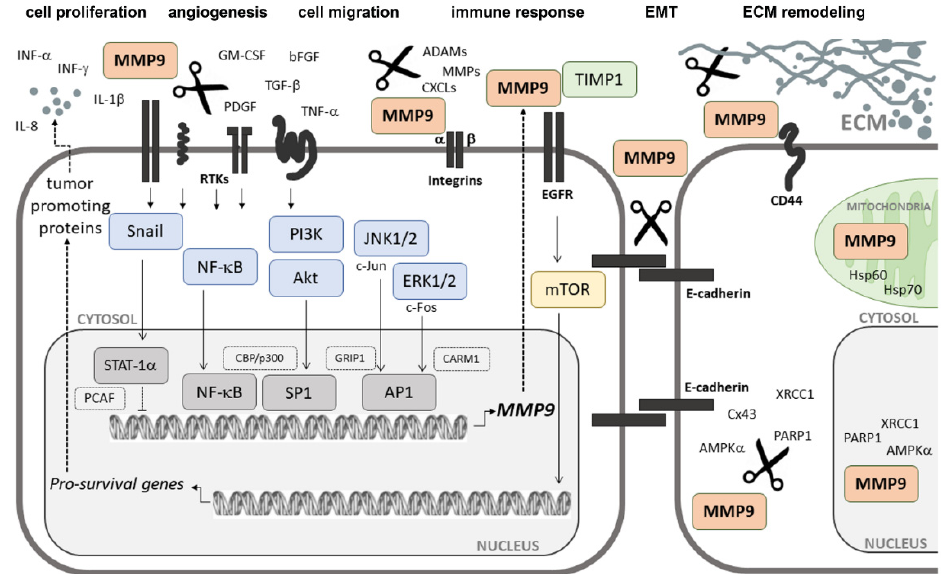
Figure 2. Schematic representation of the signaling pathways involved in MMP9 expression. The var- ious extracellular signals, including proinflammatory cytokines (TNF- α , IL-8, and IL-1 β ) and growth factors (TGF- β , PDGF, and bFGF), can bind to their receptors and activate downstream signaling cascades involved in the activation of transcription factors (NF- κ B, SP1, and AP1), which can than bind to specific sequences of the MMP9 gene promoter to trigger transcription. Transcription factors activate transcription in cooperation with additional transcriptional cofactors (CBP/p300, GRIP1,